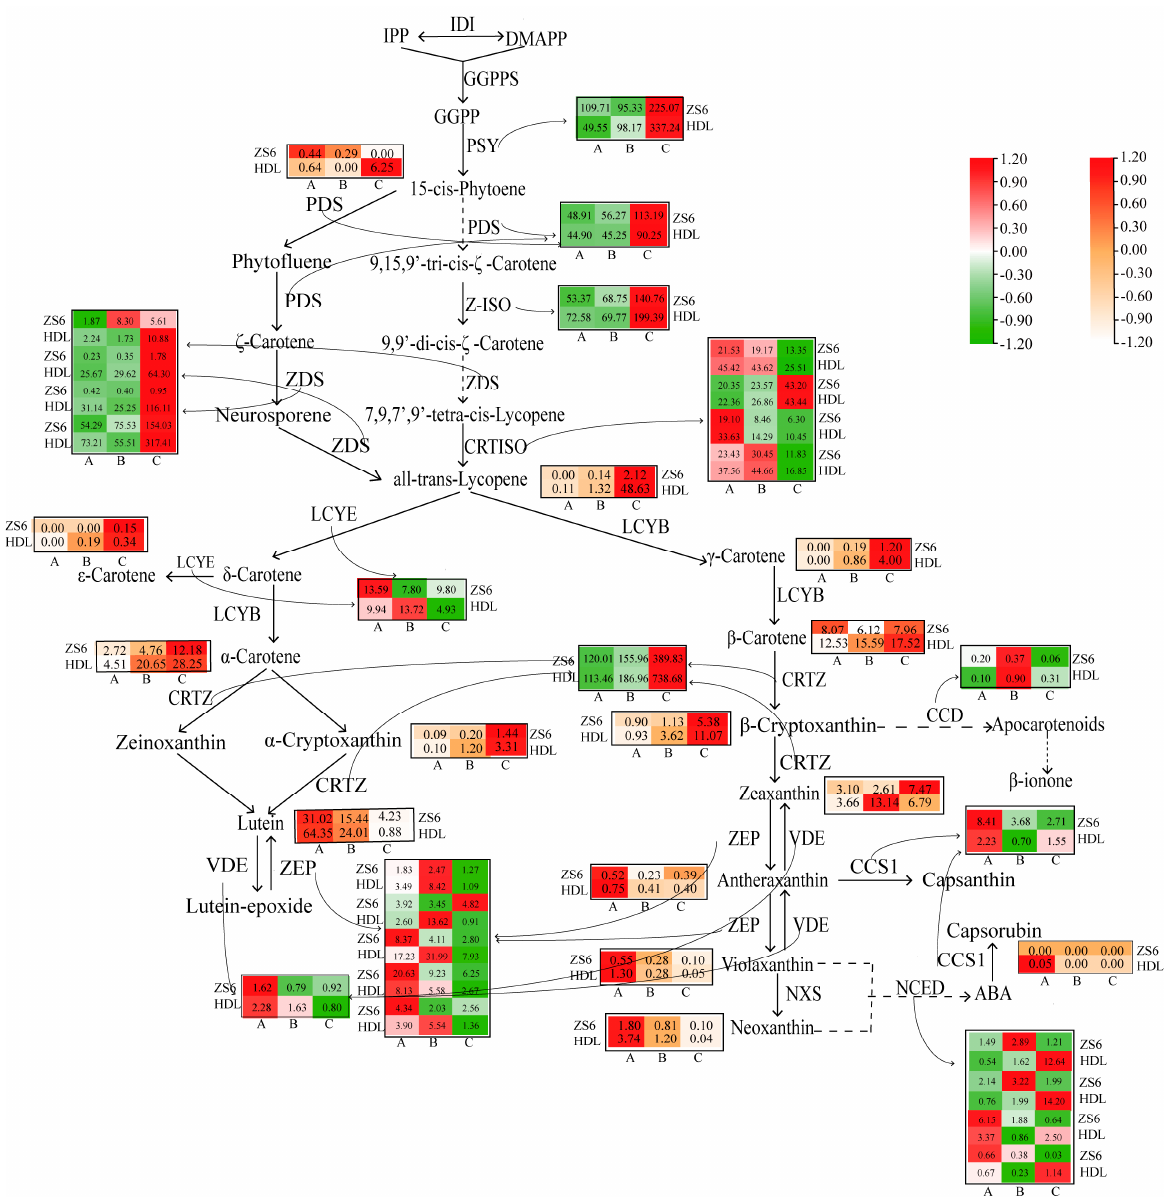
Figure 7. Carotenoids’ metabolic pathways in persimmon fruits. At the upper right, there are two color bars. The bar from green to red indicates the level of gene expression, and the values in the colored boxes are the fpkm values of the genes. The bar from yellow to red indicates the level of metabolite accumulation, and the values in the colored boxes are the relative contents of metabolites. The PSY gene is the first carotenoid biosynthesis gene isolated from plants. Its func ‐ tion is to catalyze the head ‐ to ‐ head joining of two GGPP molecules to generate symmet ‐ rical C 40 phytoene, which is the first key reaction in the carotenoid biosynthesis pathway. The PSY gene of ‘Zhongshi No. 6’ was found to be highly expressed in stage A, while the expression level was higher in stages B and C of ‘Hongdenglong’, which could be the primary factor for the higher accumulation of total carotenoids in ‘Hongdenglong’ com ‐ pared to ‘Zhongshi No.6’. The genes of PDS , ZDS , Z ‐ ISO , and CRTSO are related to